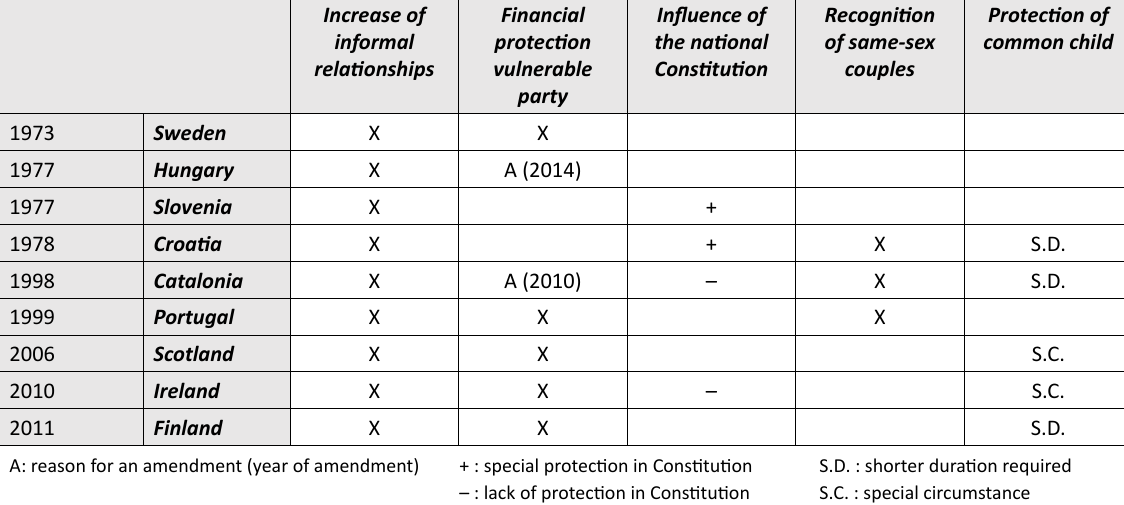
Table 3 Reasons for regulation of informal relationships in nine European jurisdictions Increase